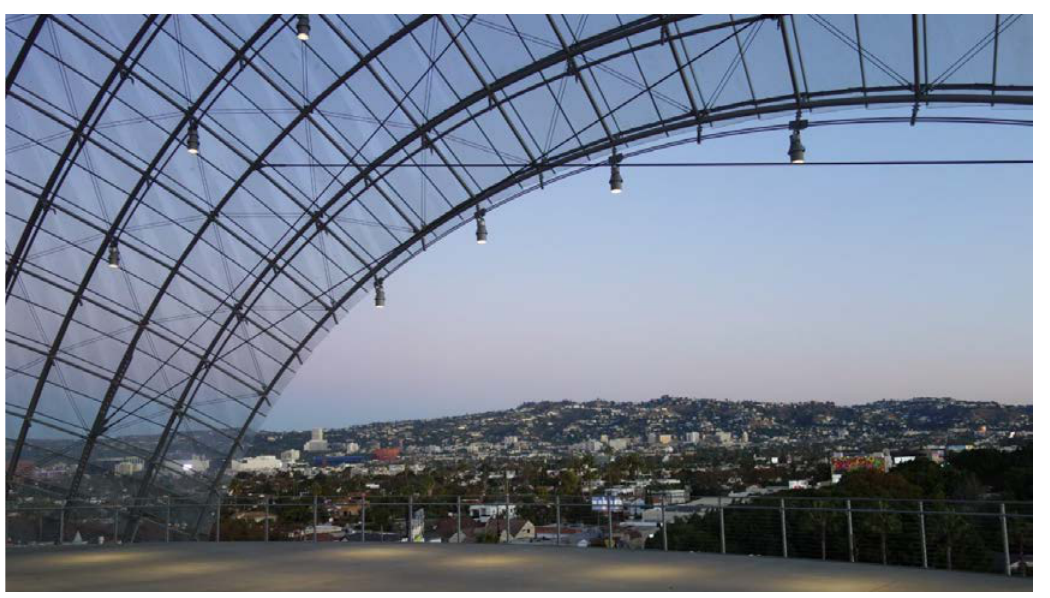
Fig. 32 Completed glass dome in November 2019. Image: Knippers Helbig .